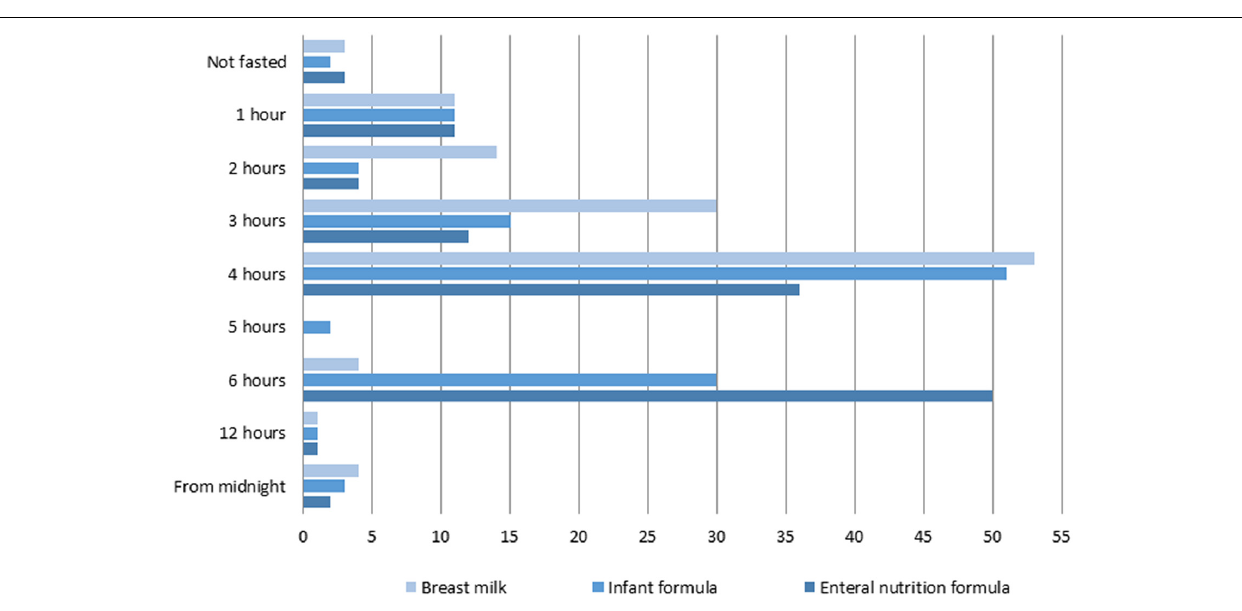
FIGURE 2 | Number of PICUs showing various lengths of fasting depending on feed